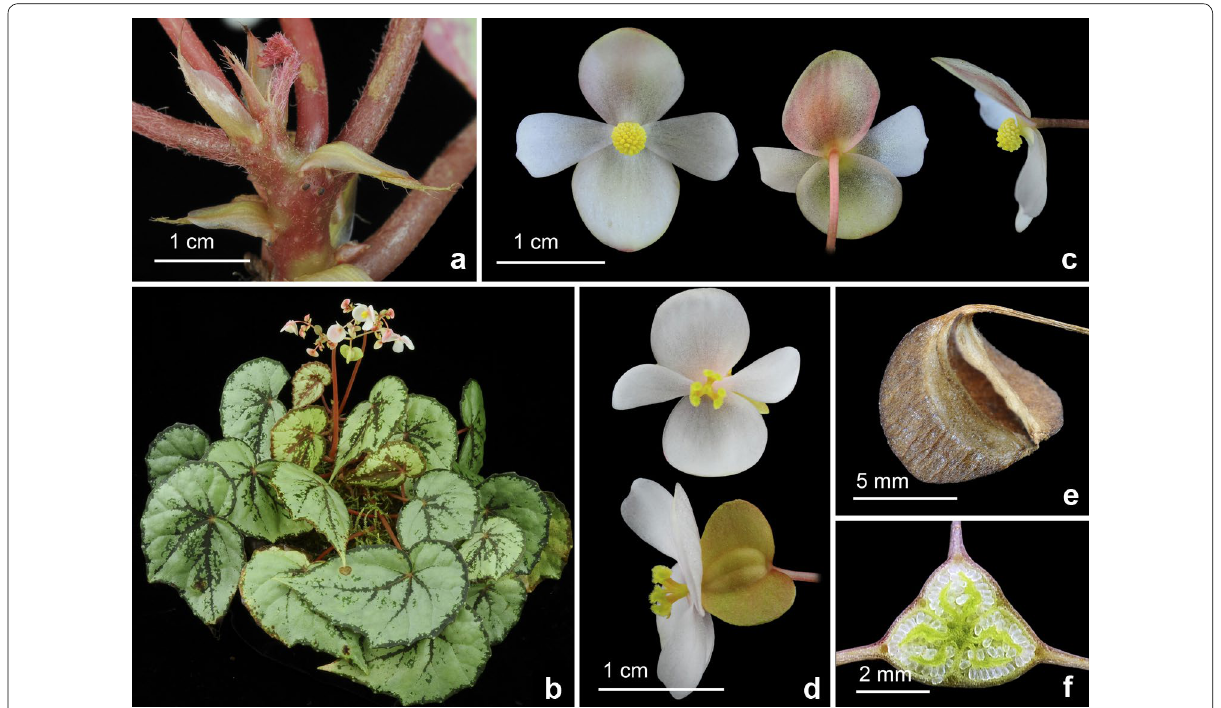
Fig. 8 Begonia sykakiengii R. Rubite, C.‑I Peng, C.W. Lin & K.F. Chung. a Apical part of a rhizome, showing stipules and petioles; b habit; c staminate flowers; d pistillate flowers; e capsule; f cross section of an immature capsule